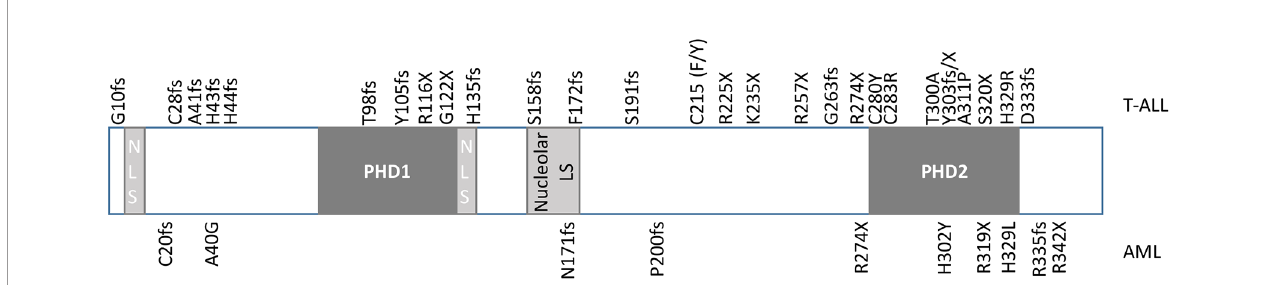
FIGURE 1 | Diagram of PHF6 . PHF6 has two imperfect PHD-like zinc fi nger domains (PHD1 and PHD2), two nuclear localization signals (NLS), and one nucleolar localization signal. Mutations originally identi fi ed in T-ALL by Van Vlierberghe et al. (4) are identi fi ed at the top of the diagram, whereas mutations originally identi fi ed in AML by Van Vliergerghe et al. (21) are identi fi ed at the bottom of